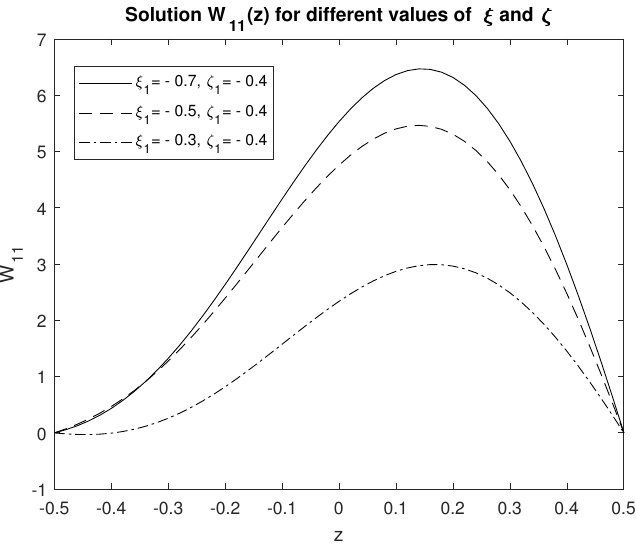
Figure 4. Solutions W 11 ( z ) for negative ξ 1